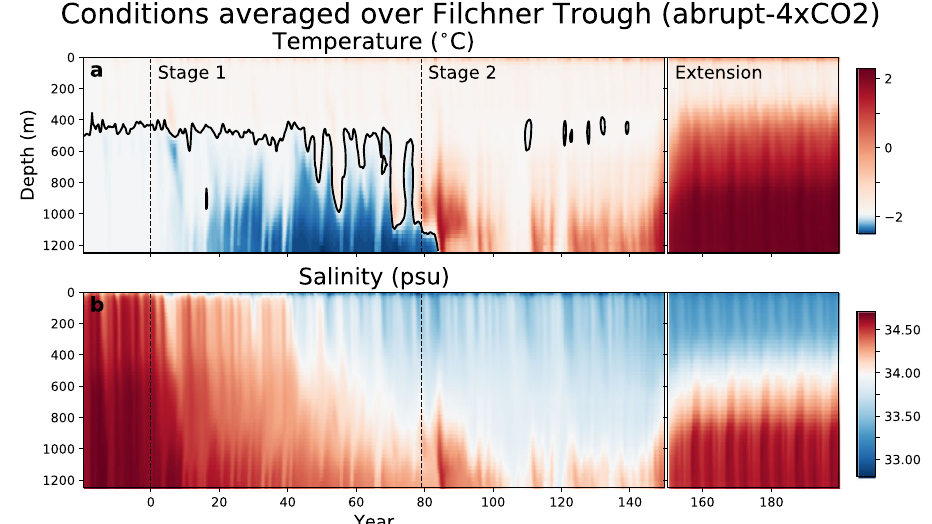
Fig. 6 Hovmöller plots (depth versus time) averaged over the Filchner Trough region in the abrupt-4xCO2 simulation and the 50-year extension. To indicate the range of pre-industrial variability, the last 20 years of the spinup are shown prior to year 0. The region is de fi ned in Supplementary Fig. 5. a Temperature in °C, with the surface freezing point contoured in black. b Salinity in psu. For both variables, the 12-month running mean is shown; note also the nonlinear colour scales. The dashed vertical lines show the beginning of the transient simulation (year 0) and the beginning of Stage 2 (year 79).